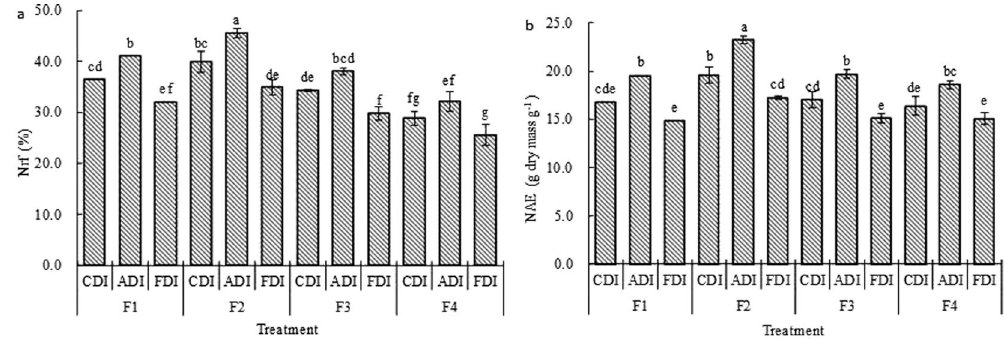
Figure 3. Effects of irrigation method and N treatment on nitrogen apparent recovery fraction (N rf ) ( a ) and nitrogen agronomic efficiency (NAE) ( b ) of sweet-waxy maize. Data points are averaged values ± standard errors (n = 3), different small letters on the bars are significantly different ( P < 0.05), and the same letters are not significantly different ( P >